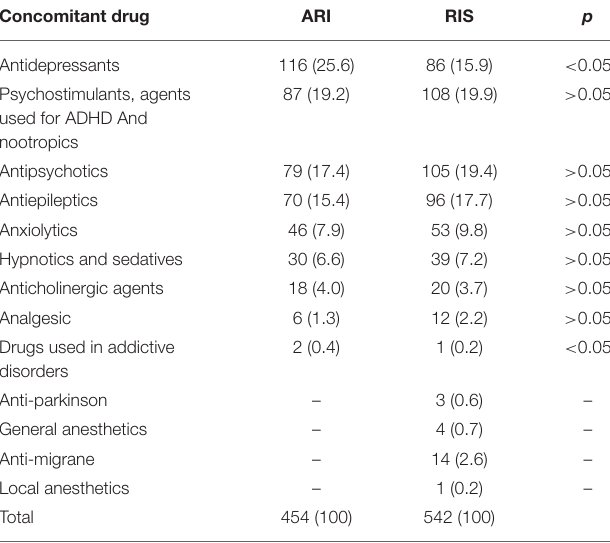
TABLE 10 | Distribution of other concomitant drugs reported with aripiprazole and risperidone belonging to the Anatomical Therapeutic Chemical (ATC) N group third level: drugs acting on nervous